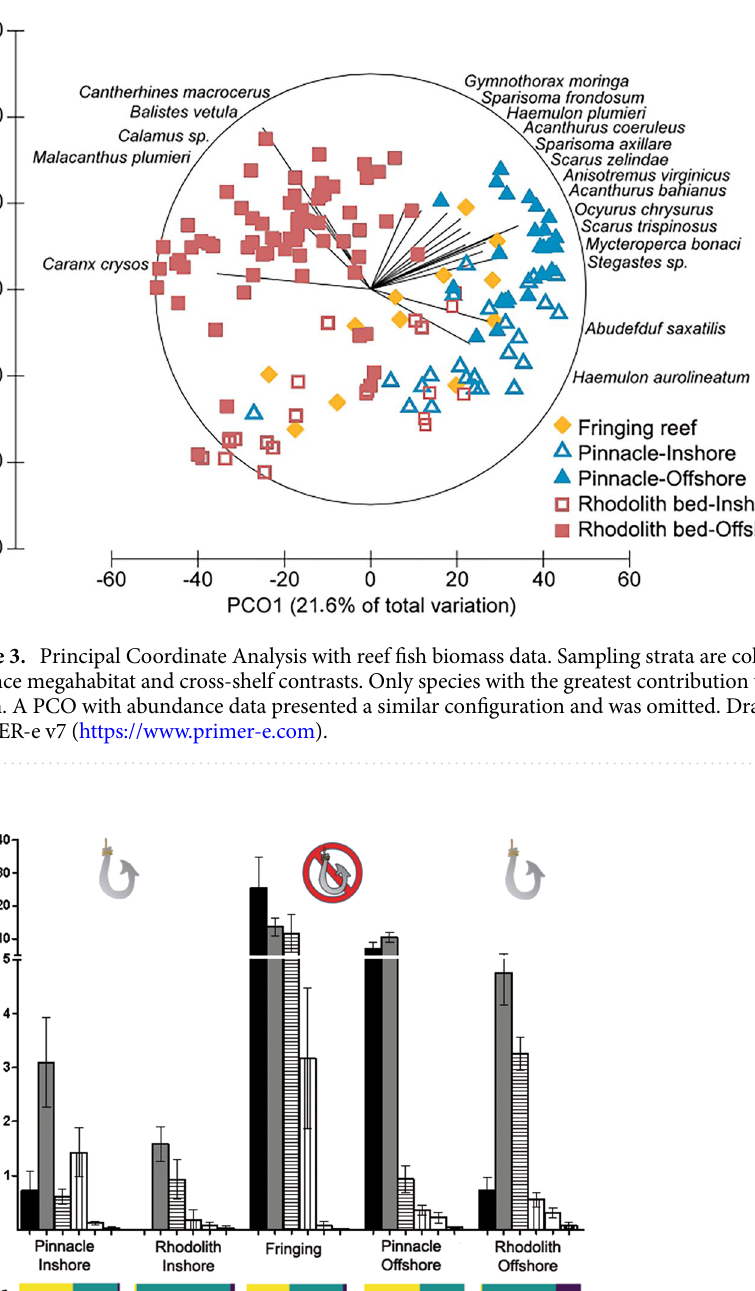
and non-linearly to habitat structure and to the variation in the amount of light reaching the bottom (Supple- mentary Fig. S2 online). Light at bottom integrates depth and turbidity in a single and ecologically meaningful variable, and captures the major ecological features across coral reef depth gradients 14,31 . The effects of light at bottom over reef fishes seems to be largely indirect and associated with trophic (e.g. grazing and predation on small invertebrates) and non-trophic (e.g. shelter from predators) connections with the benthos 31 .